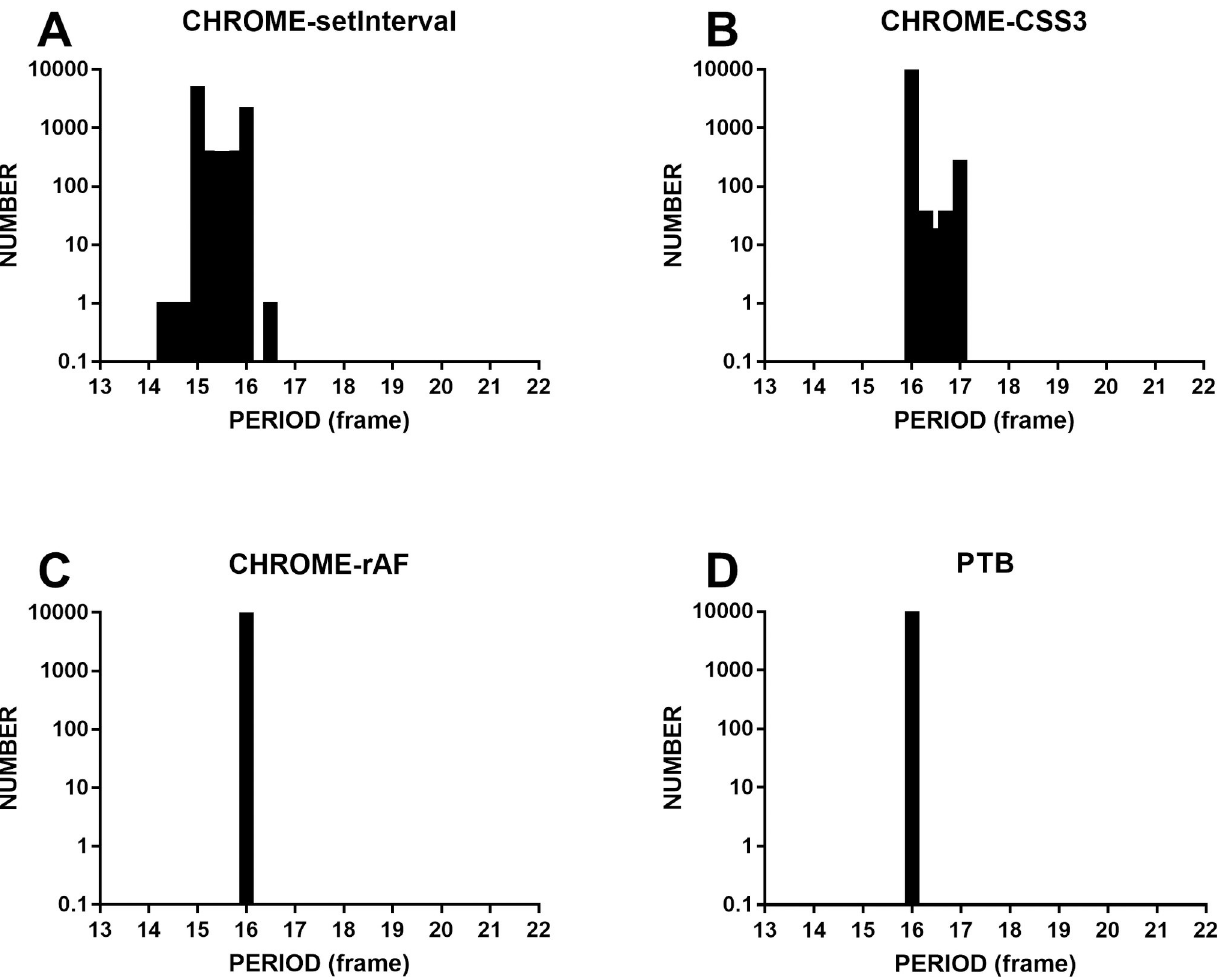
Fig 3. The four histograms show the different methods using Chrome and PTB to show 10,000 periodic distributions of grating stimuli. Bar height indicates the number of gratings distributed over the period. The ordinate is the logarithmic base 10 for showing small numbers. A: illustrates the periodic distribution of gratings designed by setInterval, and the distribution is relatively scattered. B: illustrates the periodic distribution of gratings designed by CSS3, and the distribution is also relatively scattered. C: illustrates the periodic distribution of gratings designed by rAF, and the distribution is concentrated at the 16th frame. D: illustrates the periodic distribution of gratings designed by PTB, and only one bar stands at the 16th frame. C and D: indicate that the timing accuracy produced by rAF is as good as that of PTB.